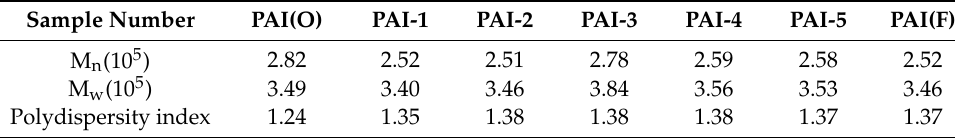
Table 1. Molecular weight and polydispersity index of synthesized PAI materials.